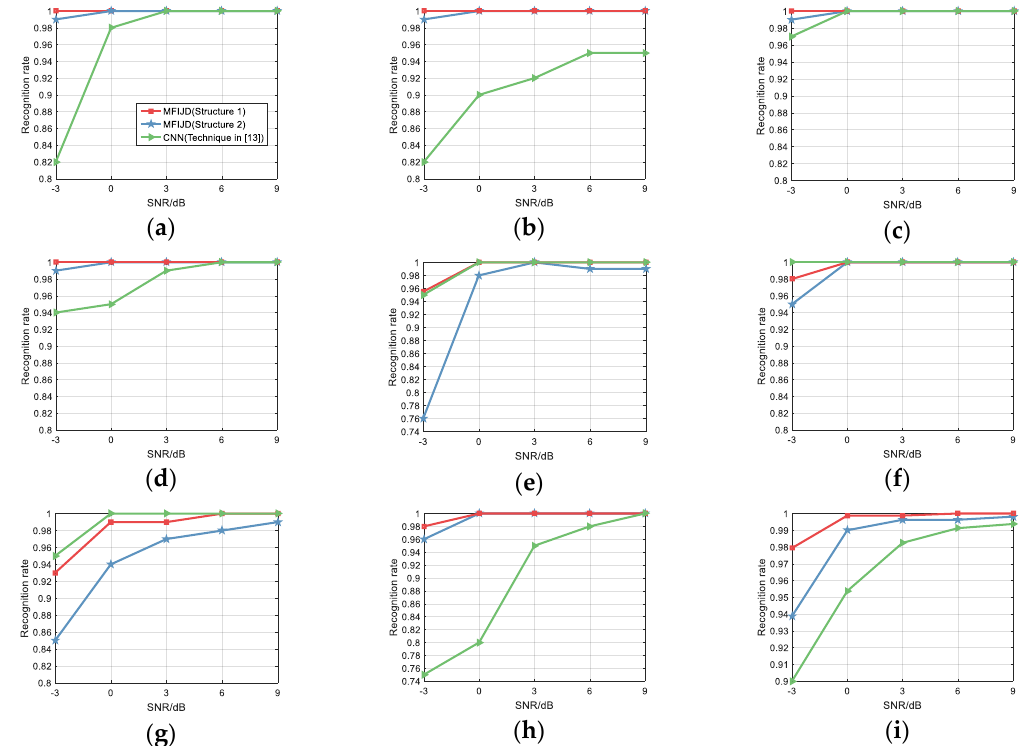
Figure 18. Comparison with the waveform classification in [13]: ( a ) Frank; ( b ) LFM; ( c ) Costas; ( d ) BPSK; ( e ) T1; ( f ) T2; ( g ) T3; ( h ) T4; and, ( i ) Overall.